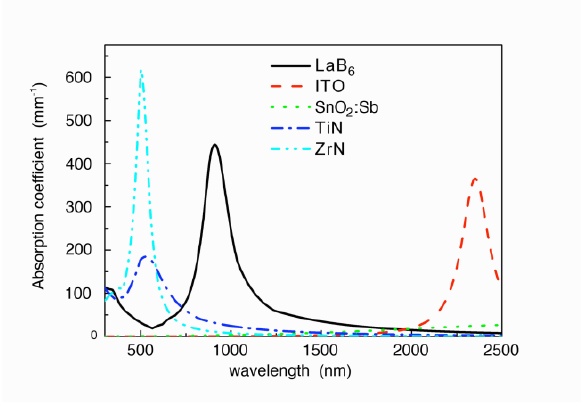
Fig. 5. Resonance plot of various plasmonic nanoparticles in TiO 2 . The different peak locations follow from the changes in carrier den- sities in each material and the sharpness of each peak depends on carrier relaxation rates. TiN and ZrN do not yield visually clear glazings, while ITO nanoparticles have a resonance, which only weakly impacts on solar transmittance unless the particle loading or fill factor is very much higher than that in LaB 6 , which is ideally located